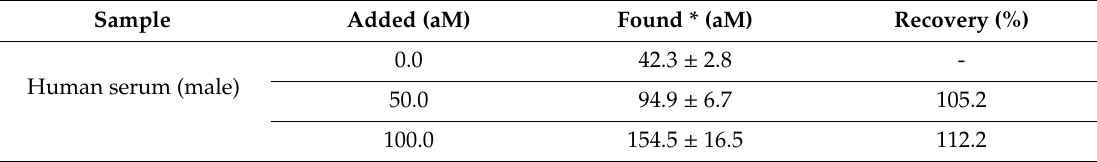
Table 1. Recovery results of detecting cholesterol in human serum